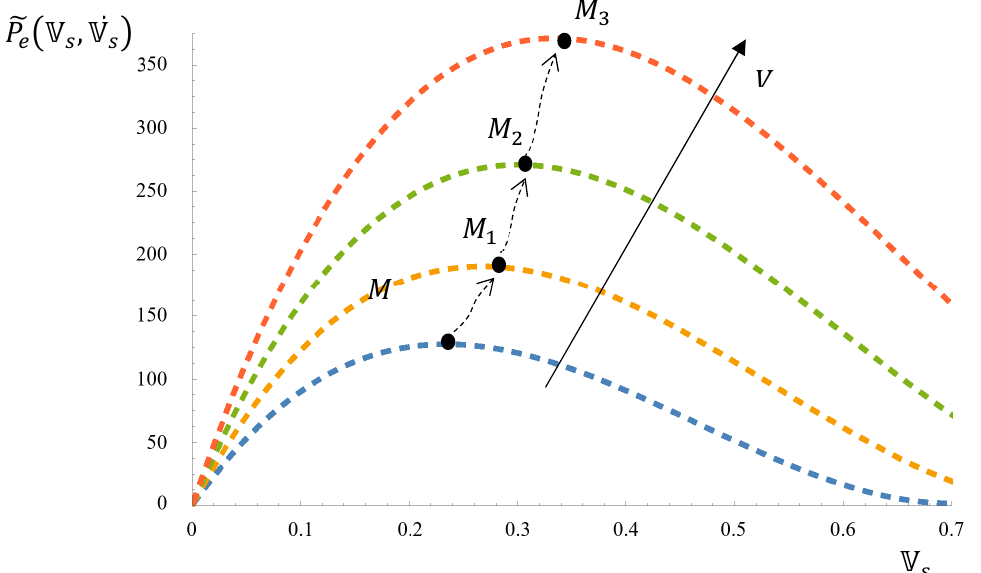
Figure 4. Power extraction for different wind speed 𝑉 and given the dimensionless rotor acceleration 𝕍(cid:4662) (cid:3046) in function of the dimensionless rotor speed 𝕍 (cid:3046) .